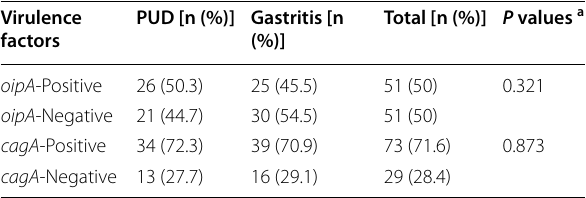
Table 2 Status of oipA and cagA gene of H. pylori in PUD and gastritis infected individuals